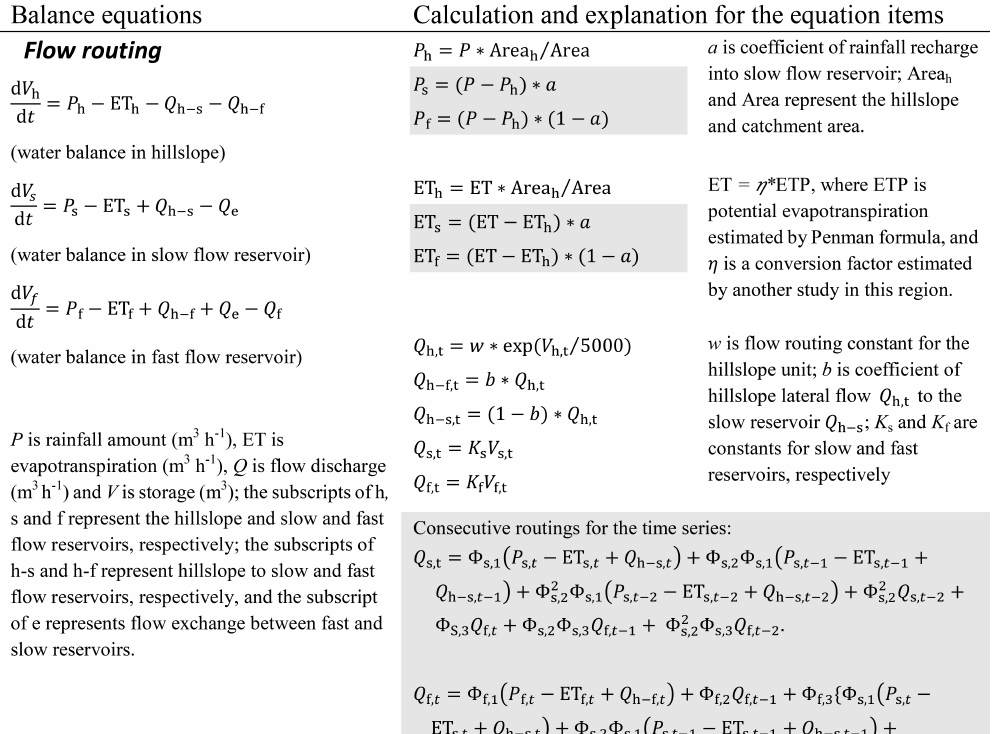
Table A1. Water/isotope/age flux equations of the